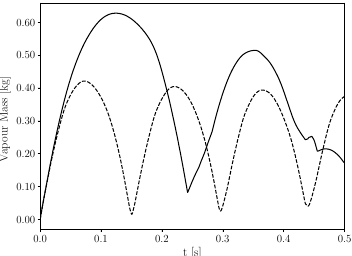
Figure 11. Evolution of phase masses in time. Legend: ( ) liquidColumn ; ( ) cavitatingTank